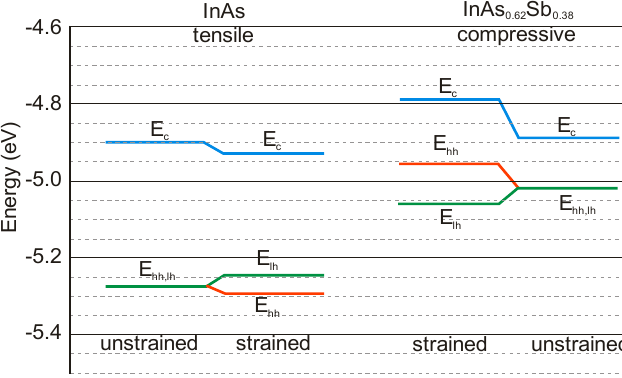
Figure 23. The energy band profiles of unstrained and strained InAs/InAs 0.62 Sb 0.38 SLs (after [105]).